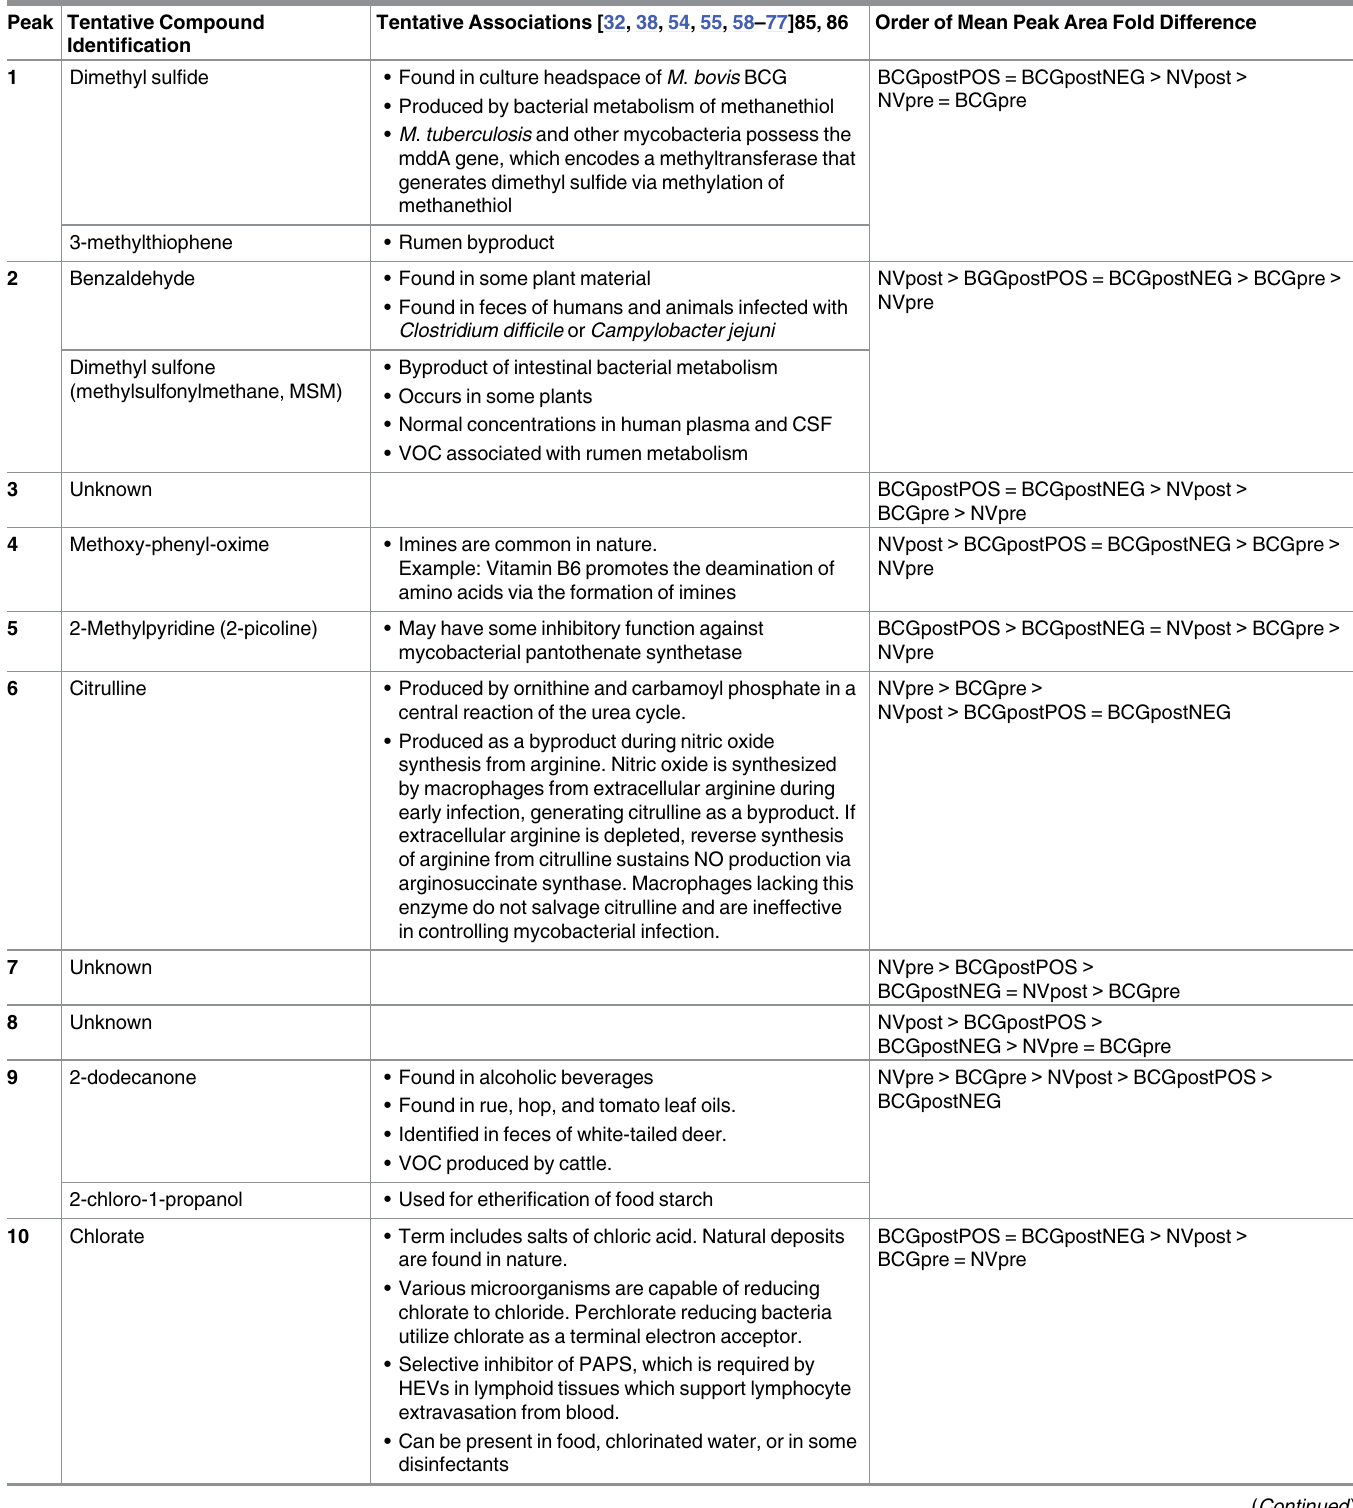
Table 6. Potential sources of peak compounds, and order of sample group mean peak